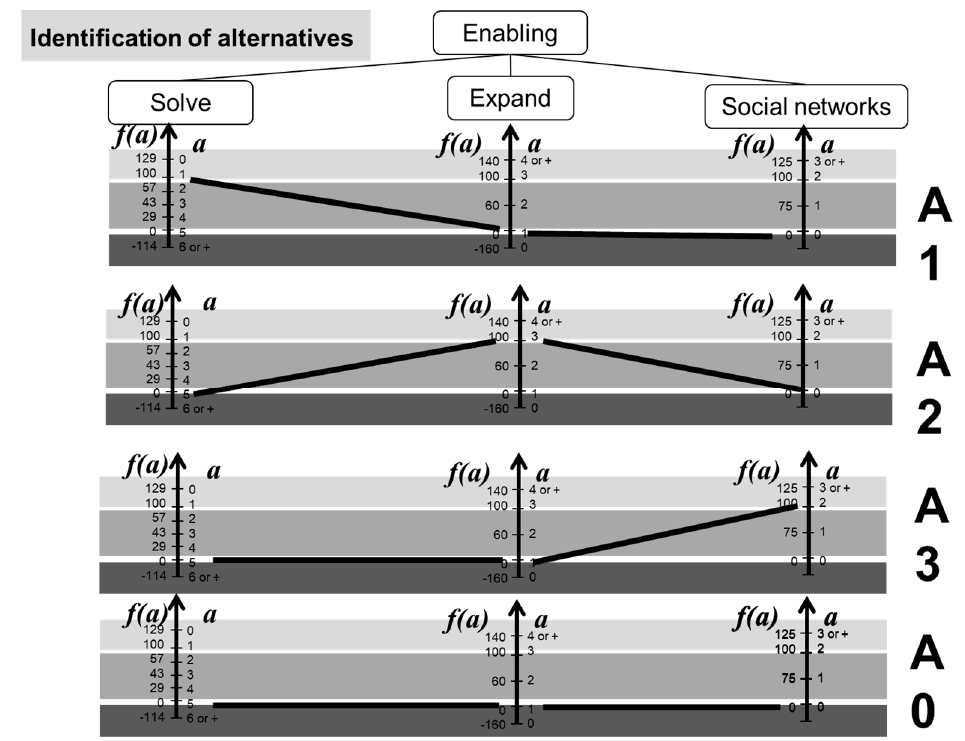
Figure 7. Activity plan with improvement actions for PVE-Expand.